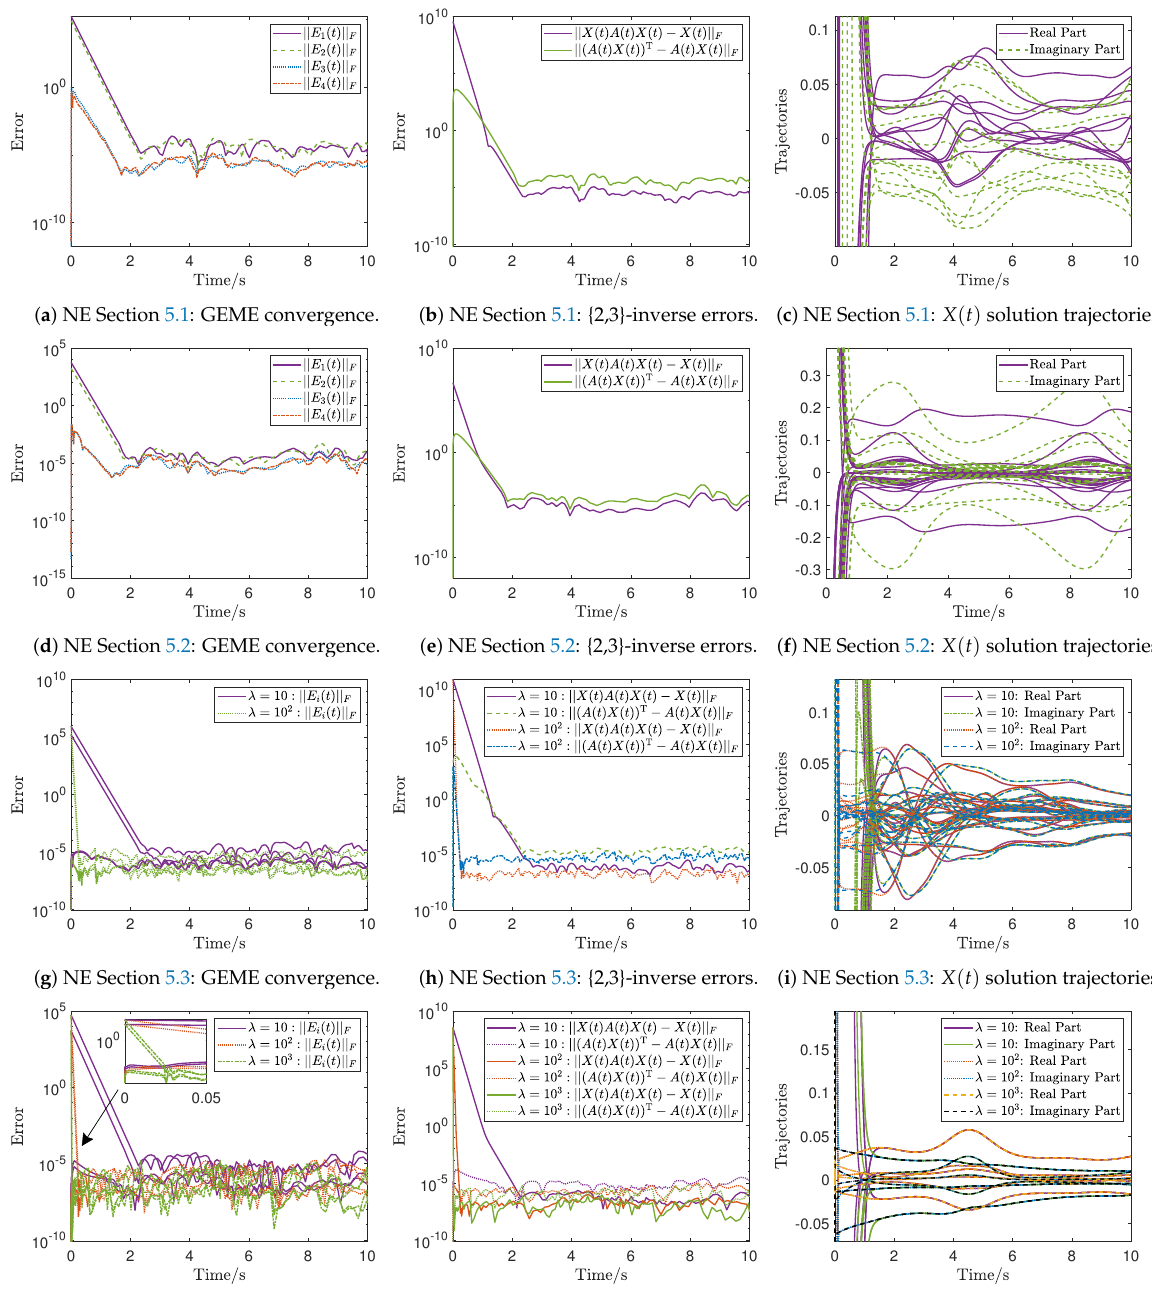
Figure 2. GEME convergence, {2,3}-inverse errors, and trajectories of the ZNN23I model’s X ( t ) solutions for the NEs in Sections